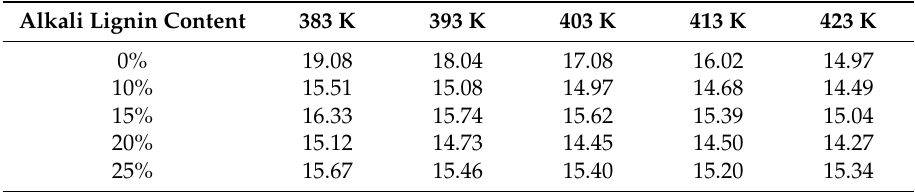
Table 1. Solubility parameters ( δ 2 ) of the mixture at different temperatures (J/cm 3 ) 0.5 . Alkali Lignin